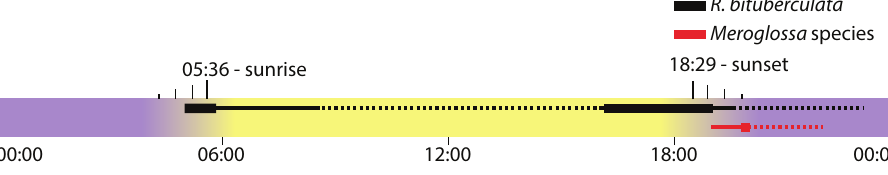
Figure 2. Foraging observations of Reepenia bituberculata and Meroglossa species. The bar shows night (purple) and day (yellow) with sunrise and sunset indicated above by longest vertical lines and civil (sun 6° below horizon), nautical (sun 12° below horizon) and astronomical (sun 18° below horizon) start and end shown by the lines decreasing in height to the left and right of sunrise and sunset, respectively. Num- bers along the bottom of the bar indicate times of day. Thick horizontal black and red lines show when R. bituberculata and Meroglossa spp., respectively, were collected or observed to be active. Thinner solid lines show frequent observation periods (observed at least every 10 mins) when no bees were observed or caught on flowers, while dotted lines indicate sporadic observation periods (observed every hour or more) when no bees were observed or caught on